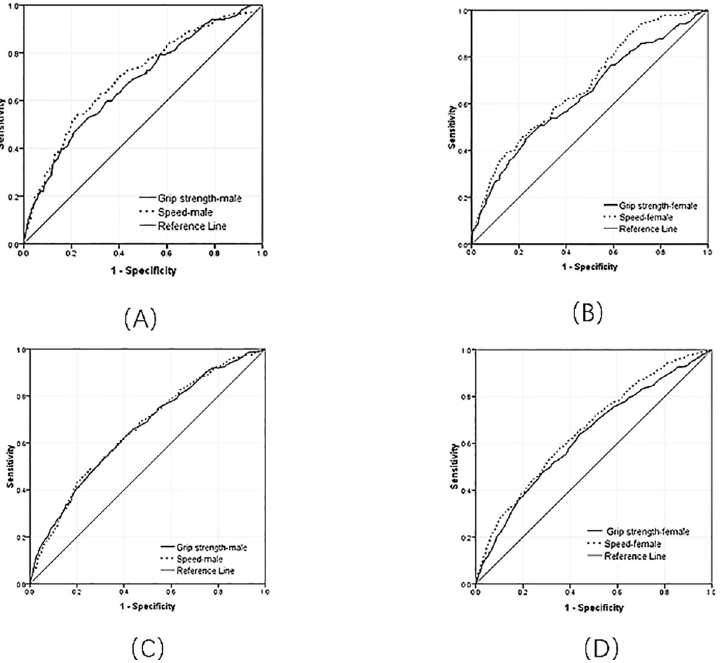
Fig 2. ROC curves for each variable for ADL and IADL disabilities. (A) ROC curves for each variable for ADL disability in males. (B) ROC curves for each variable for ADL disability in females. (C) ROC curves for each variable for IADL disability in males. (D) ROC curves for each variable for IADL disability in